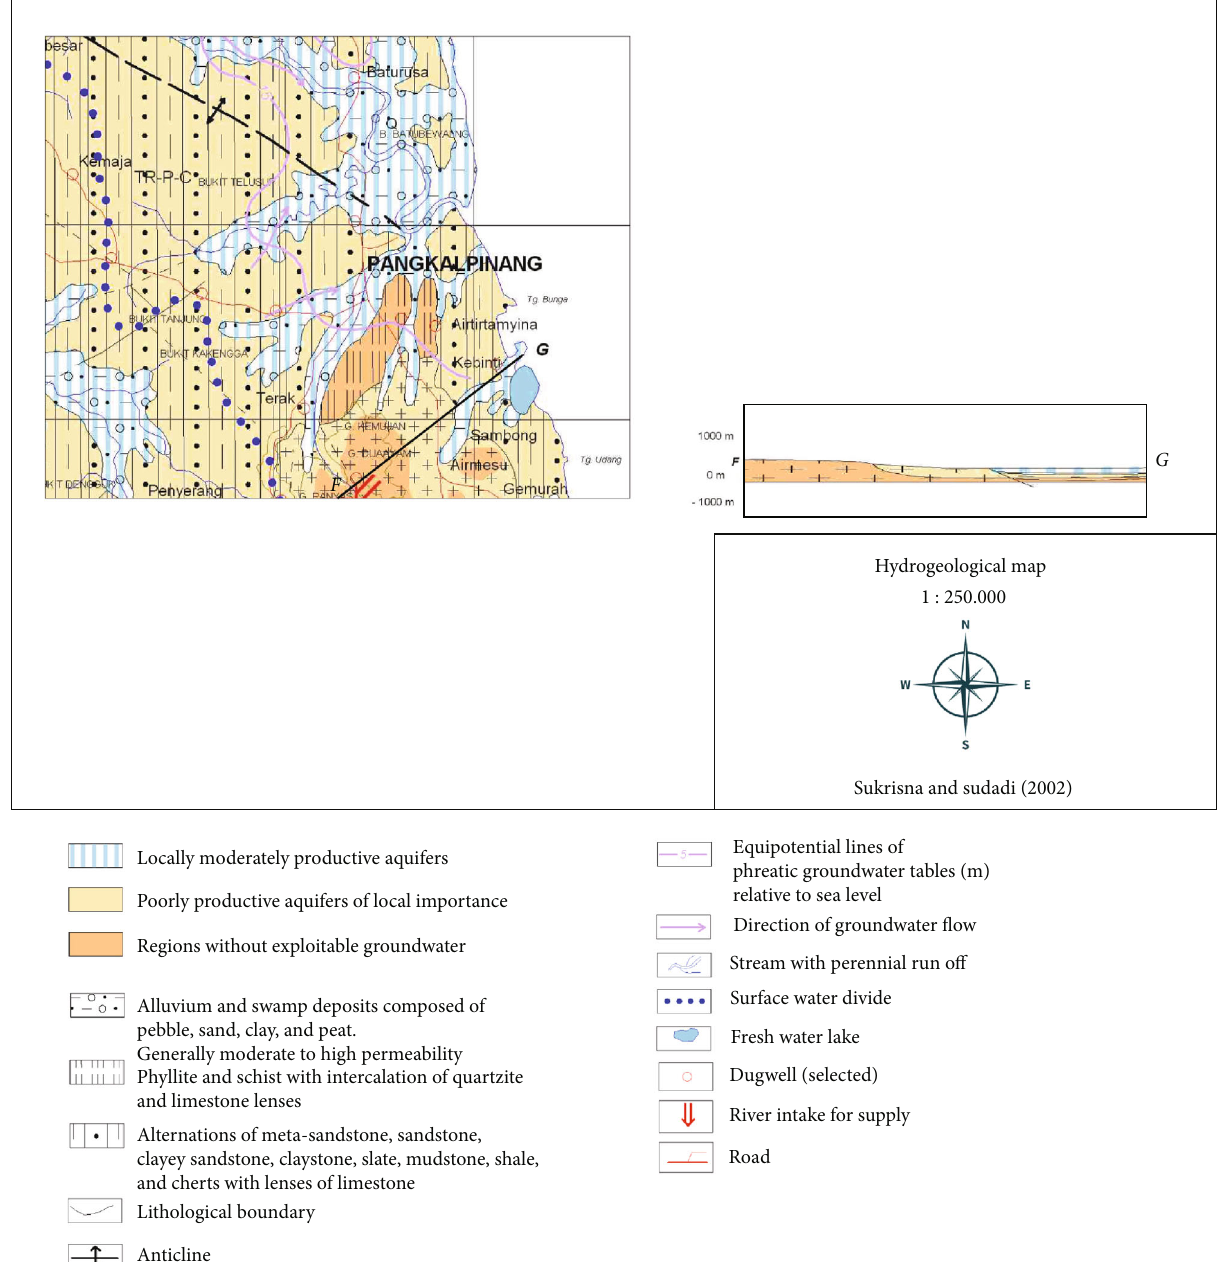
Figure 3: Hydrogeology map of study area (Sukrisna and Sudadi,